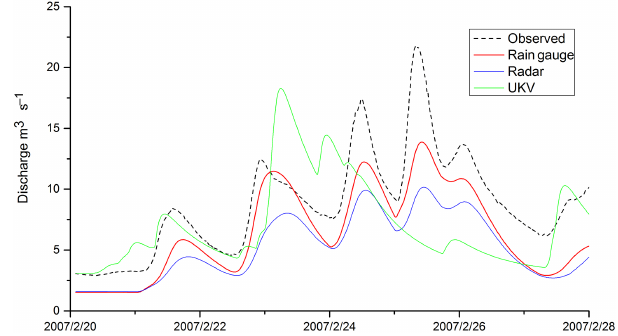
Figure 6. The comparison of flow simulation in HYPE (event Jan- uary 2007).